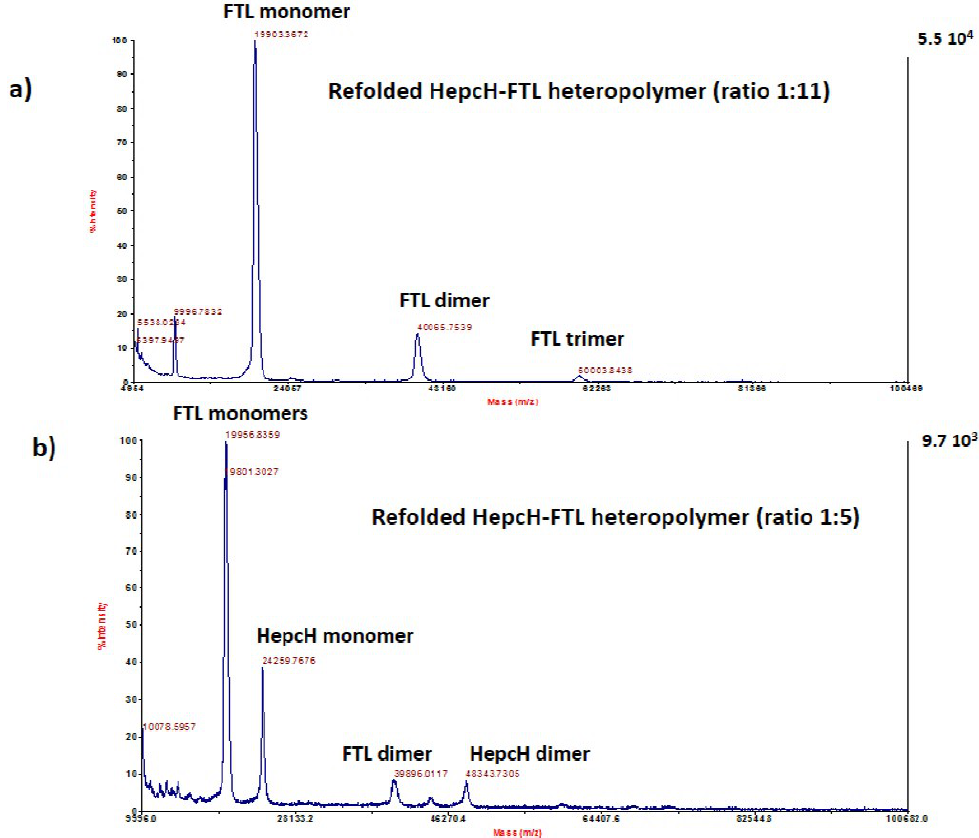
Figure 6. High-resolution MALDI-TOF/TOF mass analysis of the refolded heteropolymer HepcH- FTL. ( a ) MALDI-TOF mass analysis of the refolded HepcH-FTL heteropolymer, assembled using a molar ratio HepcH:FTL of 1:11, showing masses corresponding to FTL monomer, dimer and trimer. ( b ) MALDI-TOF mass analysis of the refolded HepcH-FTL heteropolymer, assembled using a molar ratio HepcH:FTL of 1:5, showing masses corresponding to HepcH and FTL monomers, FTL dimer and HepcH